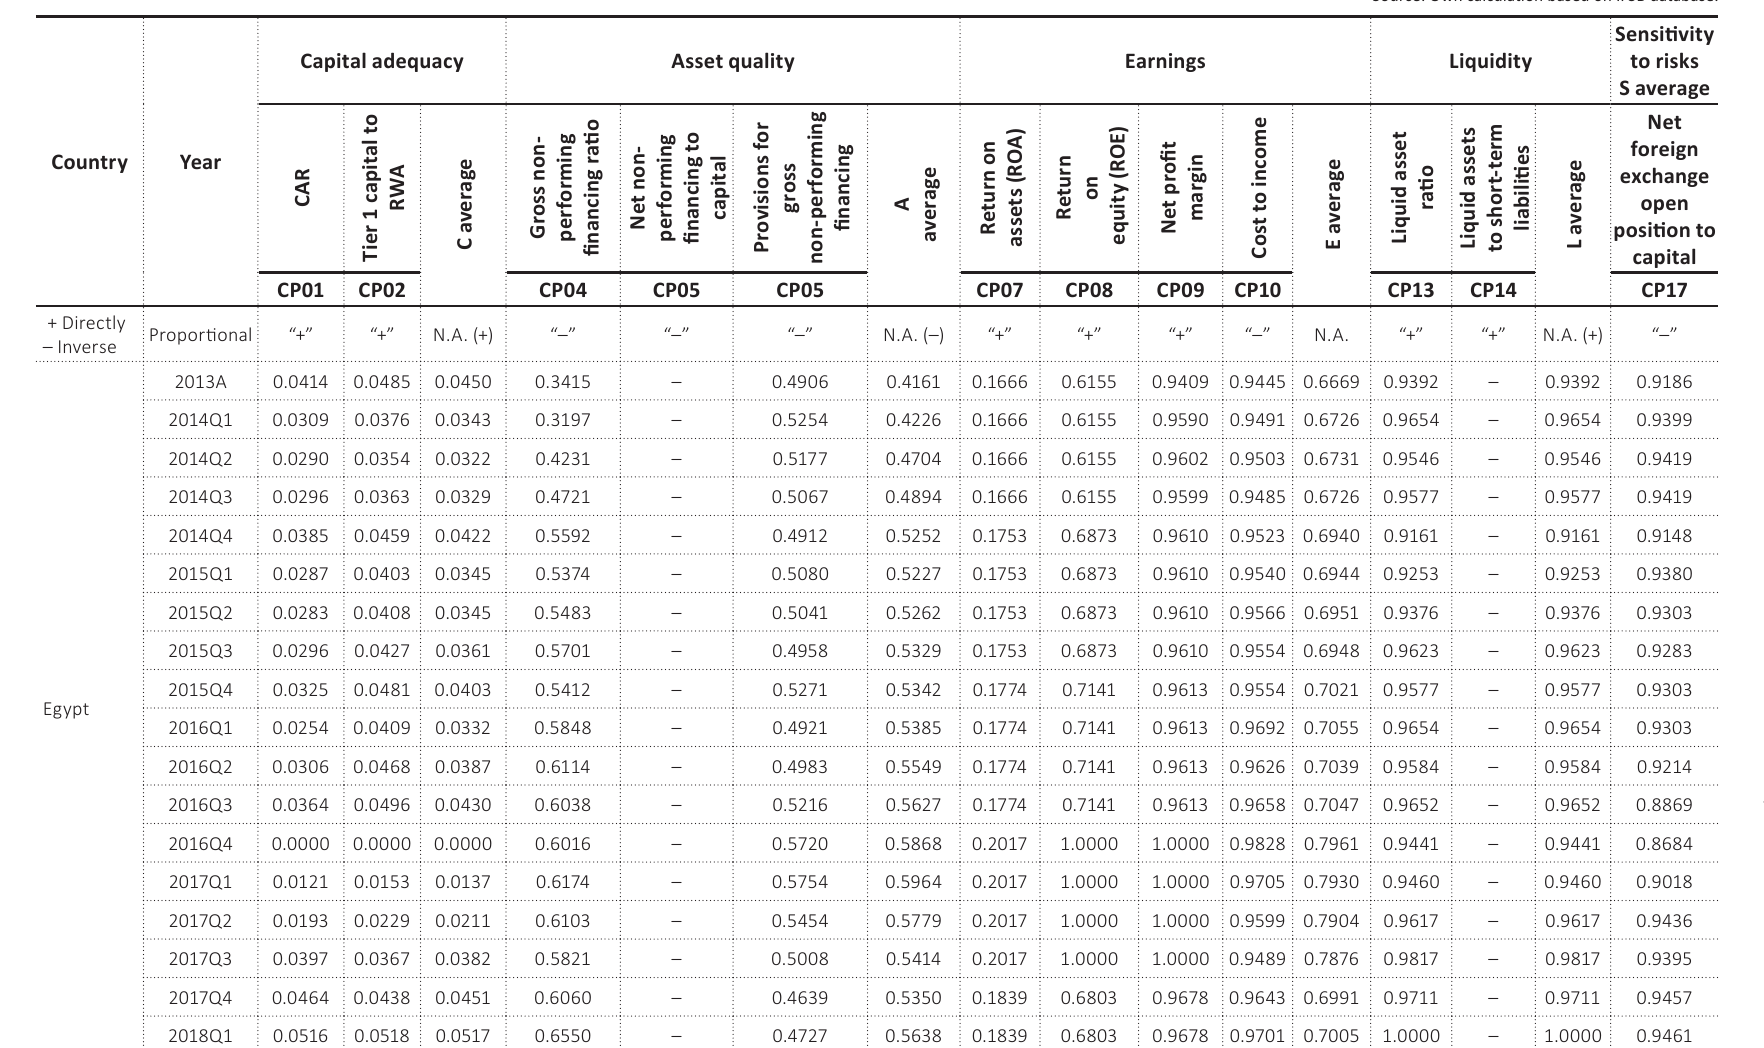
Table A2. Standard CAELS data of Egypt